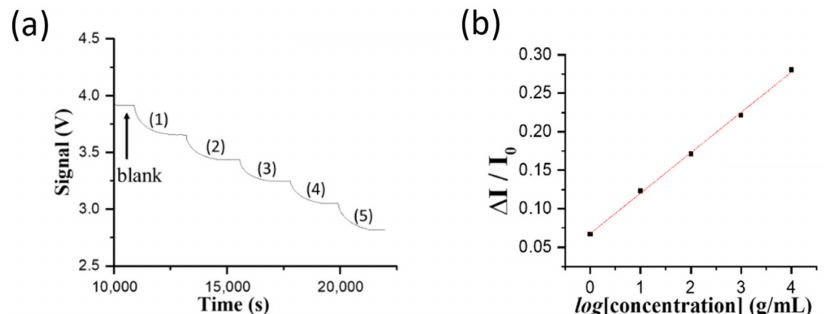
Figure 4. ( a ) The sensorgram obtained by sequentially injecting NNV standard solutions at concen- trations of (1) 1.0 × 10 0 , (2) 1.0 × 10 1 , (3) 1.0 × 10 2 , (4) 1.0 × 10 3 , and (5) 1.0 × 10 4 TCID 50 /mL in the presence of AuNP@Ab D conjugate. ( b ) The standard calibration curve of the normalized response ( ∆ I/I 0 ) versus the logarithm value of NNV concentration (log[C]).